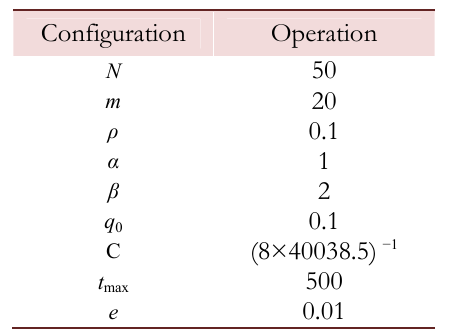
Table 1: IACA configuration.